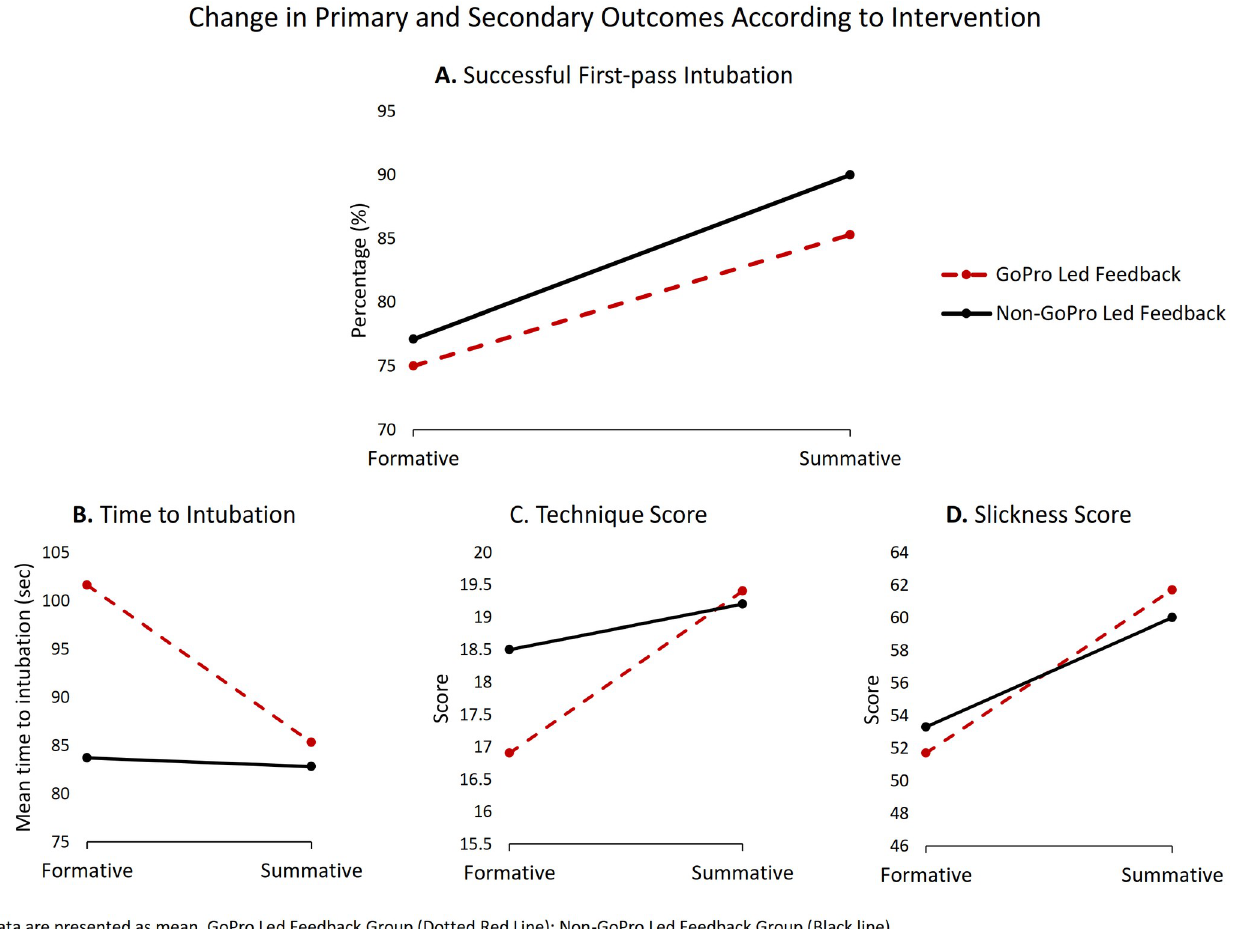
Fig 2. Change in primary and secondary outcomes according to intervention. (A) Primary outcome: Successful first-pass intubation. (B) Secondary outcome: Time to intubation. (C) Secondary outcome: Technique score. (D) Secondary outcome: Slickness score. GoPro Led Feedback Group (Dotted Red Line); Non-GoPro Led Feedback Group (Black